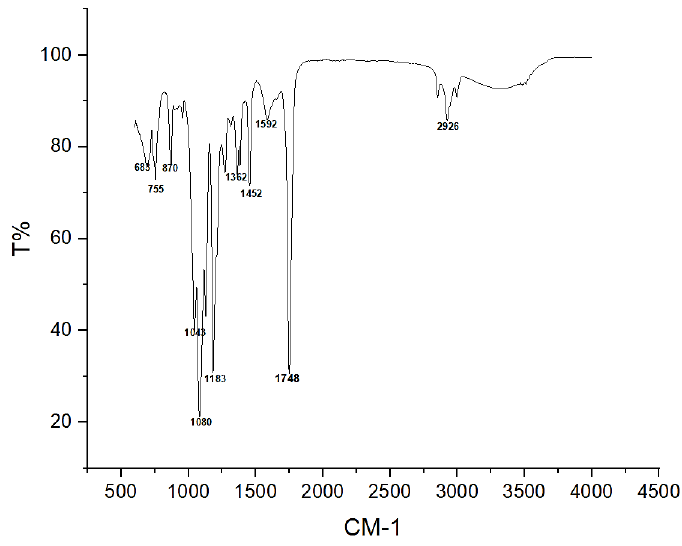
Figure 5. Graph showing the bioplastic film FTIR spectra.